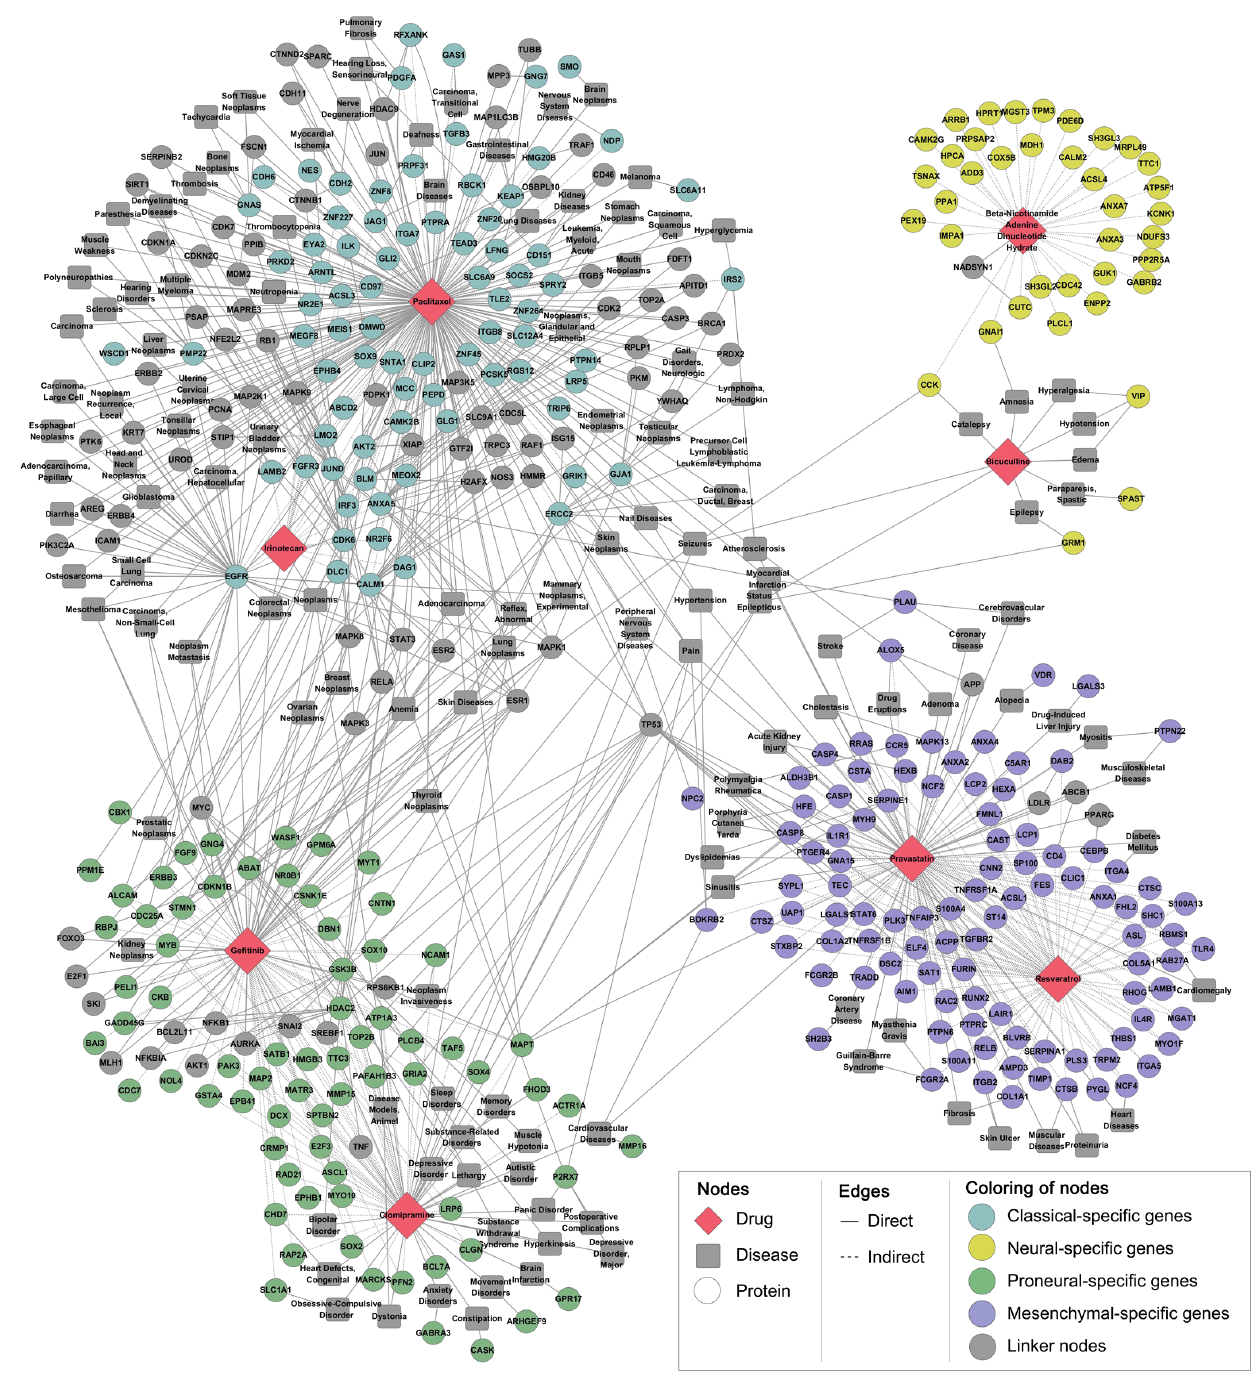
Figure 6. Network for GBM subtype-specific drug candidates. Eight drug candidates were directly/indirectly liked to a number of subtype- specific genes; Clomipramine: 57 proneural-specific genes; Gefitinib: 64 proneural-specific genes; Beta-Nicotinamide Adenine Dinucleotide Hydrate: 35 neural-specific genes; Bicuculline: 5 neural-specific genes; Pravastatin: 100 mesenchymal-specific genes; Resveratrol: 86 mesenchymal-specific genes; Irinotecan: 20 classical-specific genes; Paclitaxel: 79 classical-specific genes.